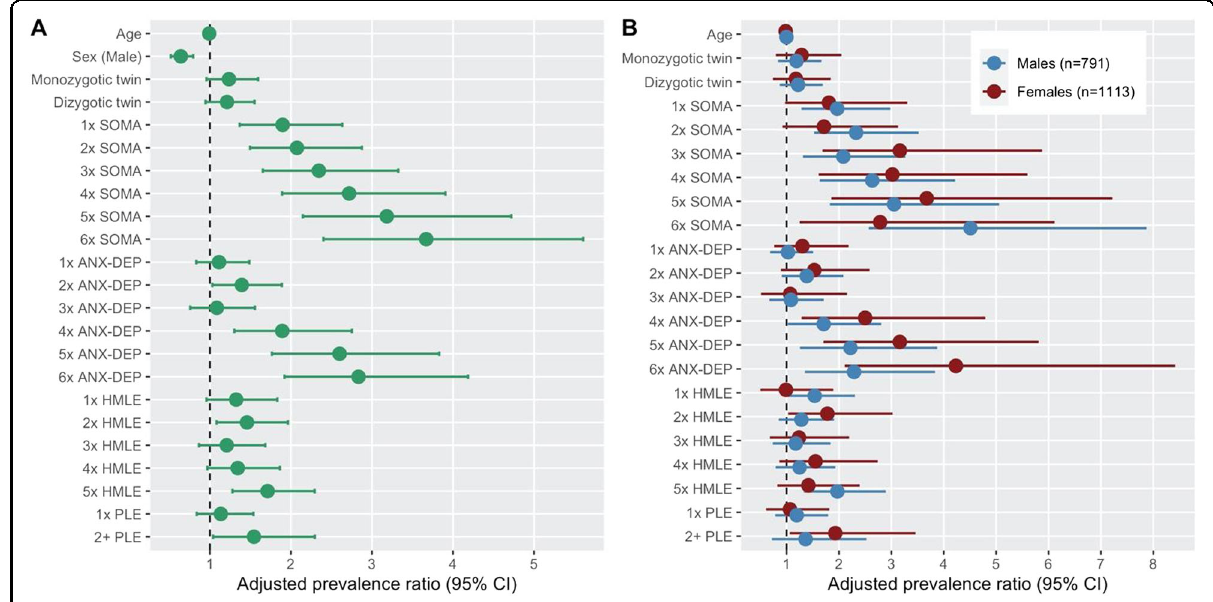
Fig. 2 Relationships between days out of role and the number of somatic, anxious-depressive, hypo-manic, and psychotic-like symptoms in a community-based cohort of young adults. A Model for total sample; B separate models strati fi ed by sex. SOMA somatic symptoms, ANX-DEP = anxious-depressive symptoms, HMLE hypomanic, PLE psychotic-like